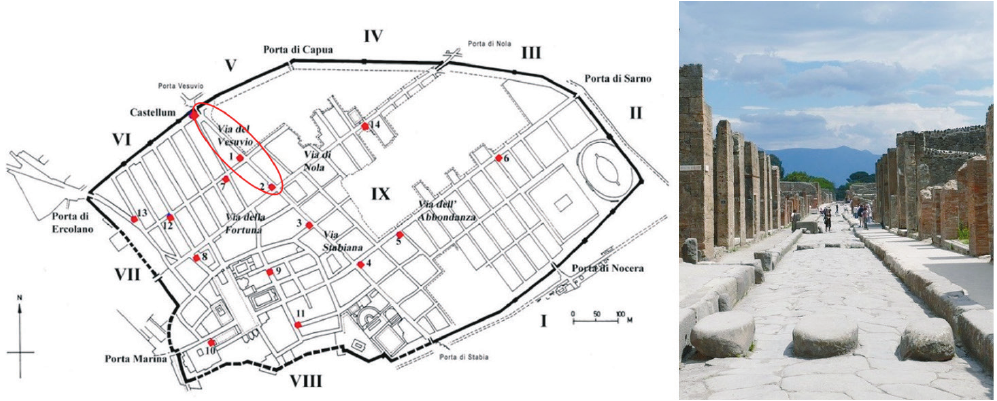
Figure 4. Plan and 3D view of the selected road element Via Del